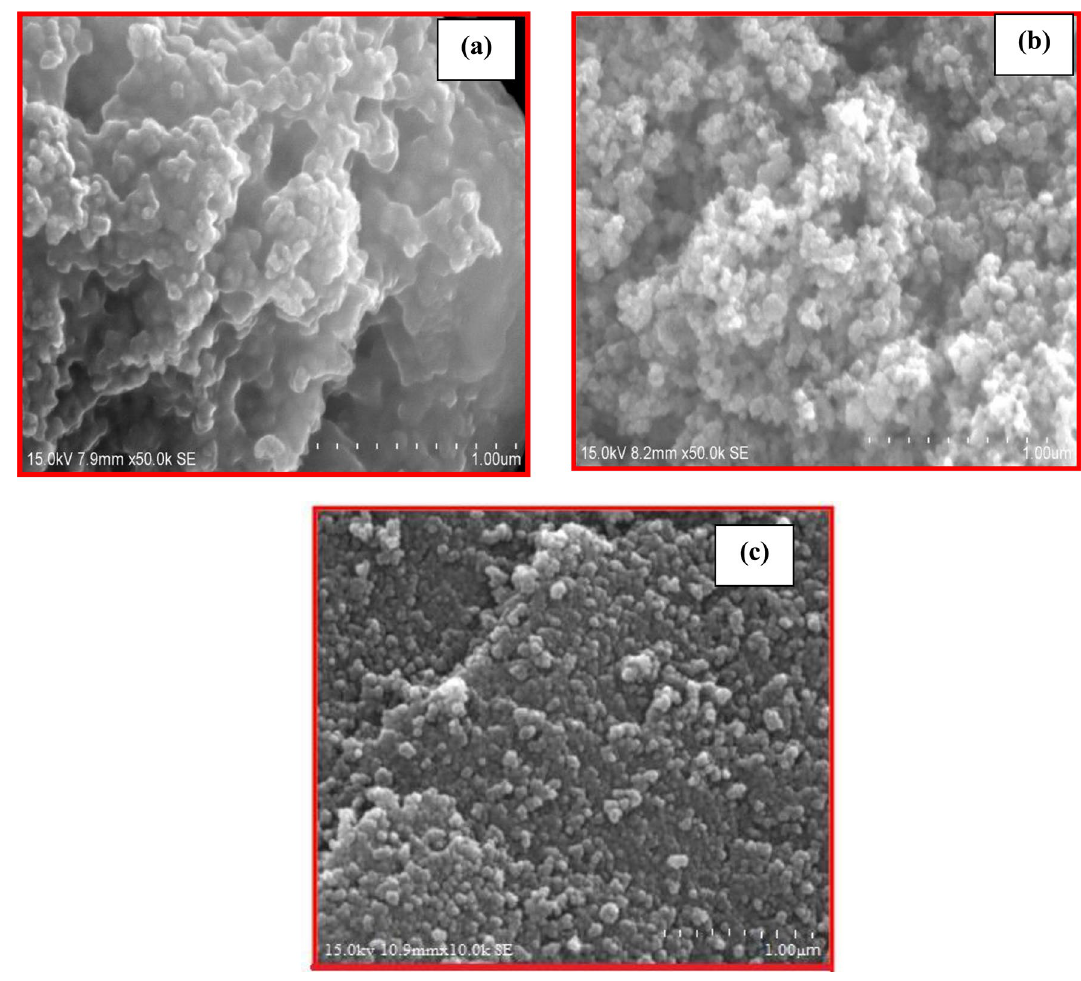
Figure 2. FE-SEM picture of ( a ) CT ( b ) CS-CT ( c ) AS-CT